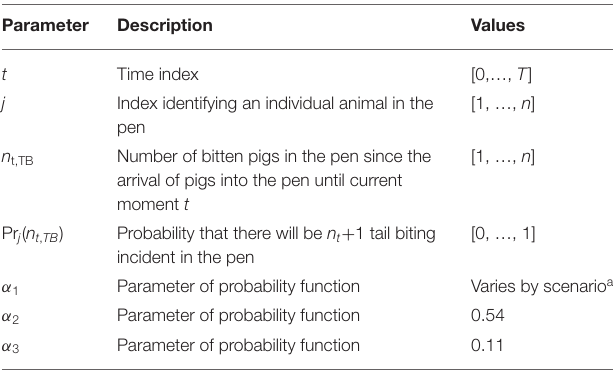
TABLE 2 | Parameters used in the model to simulate the occurrence of tail biting in a